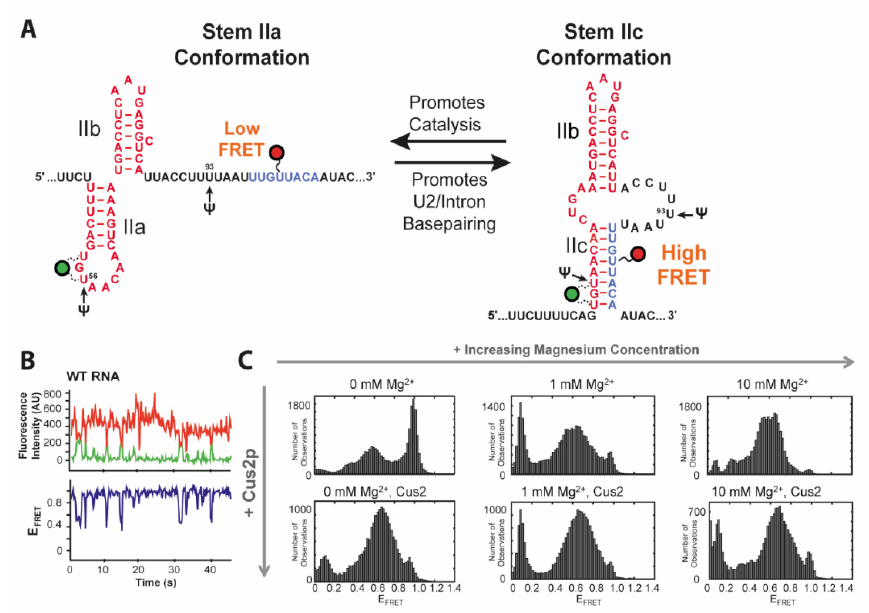
Figure 2. FRET construct and data for toggling of U2 snRNA. ( A ) The stem II of the U2 snRNA can switch between two conformations. Labeling positions in the two studies of Cy3 (green) and Cy5 (red) as well as Pseudouridylation sites are indicated. ( B ) Example FRET trajectory of U2 shows a spontaneous toggling between two FRET states. ( C ) FRET histograms of WT RNA in dependence of Mg 2+ and Cus2 concentrations. This Figure was adapted and modified from Rodgers et al. [16] and